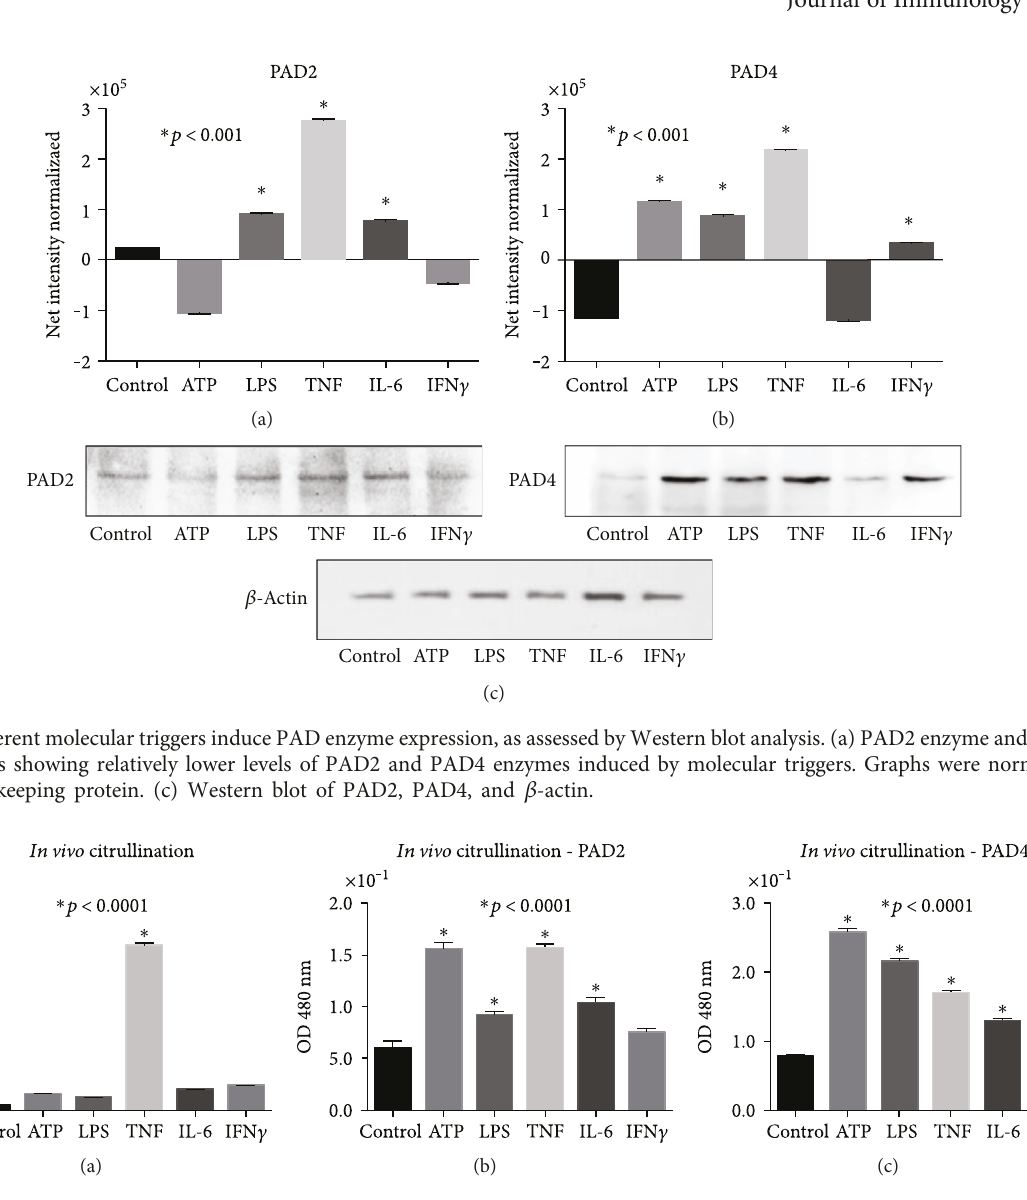
Figure 5: PAD activity. (a) In vivo PAD activity measured based on the citrullination of proteins in cell extracts using a direct ELISA assay with tissue extracts fi xed onto polystyrene plates and measuring CCP/HRP antibody, this assay shows a signi fi cant increase by TNF ( p < 0 0001 ). In vitro PAD2 activity under basal conditions in response to stimulation with di ff erent molecular stimulants; PADs were captured using anti-PAD2 or anti-PAD4 enzymes, then citrullination was detected using an exogenous reporter protein ( fi brinogen) and measured with an anti-citrulline-HRP antibody by ACELIA and di ff erence between stimulants and controls (b, c). (b) Signi fi cant di ff erences of in vitro citrullination PAD2 dependent by the e ff ect of all stimulants except IFN γ ( p < 0 0001 ); similar results were obtained by PAD4, and bars marked with an asterisk compare control with a speci fi c molecular stimulant by Student t -test